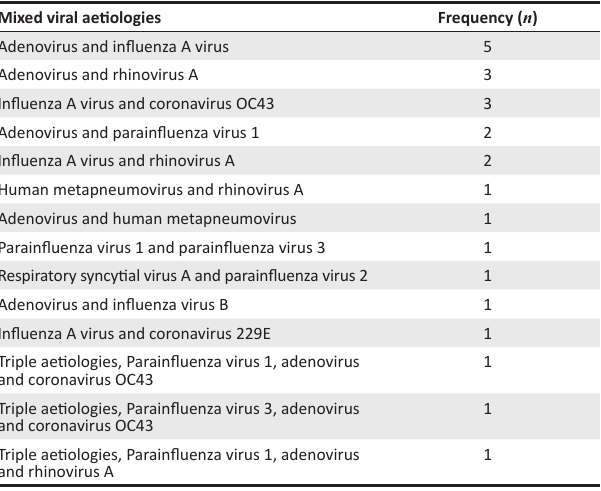
TABLE 3: Mixed infections amongst patients presenting with influenza-like illness attending Kiswa Health Center and Entebbe Hospital, Uganda, between August 2008 and December 2008; n = 24.